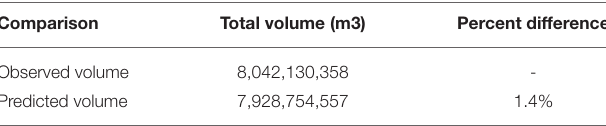
TABLE 7 | Using Cael et al. (2017) method, percent difference between the 816 observed lake volumes and the predicted volumes.